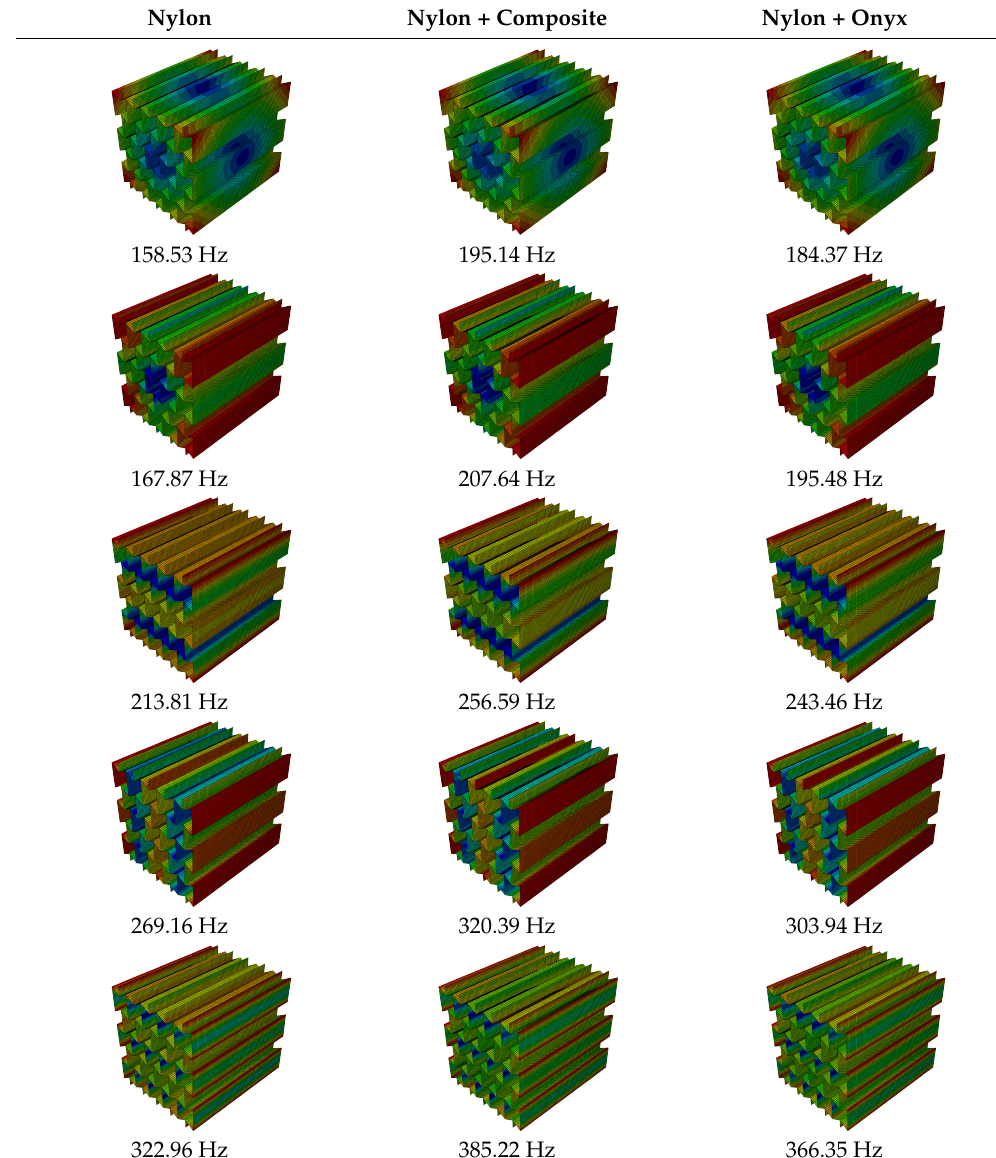
Table 10. First five paired mode shapes of Re-entrant Lattice Structure: